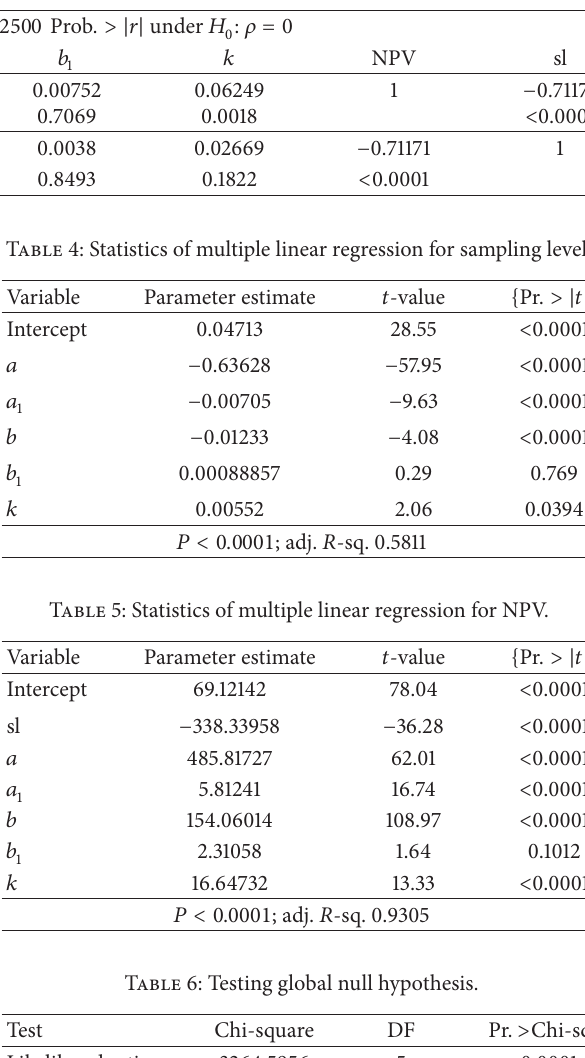
Table 3: The correlation test with test parameters and decision variables.